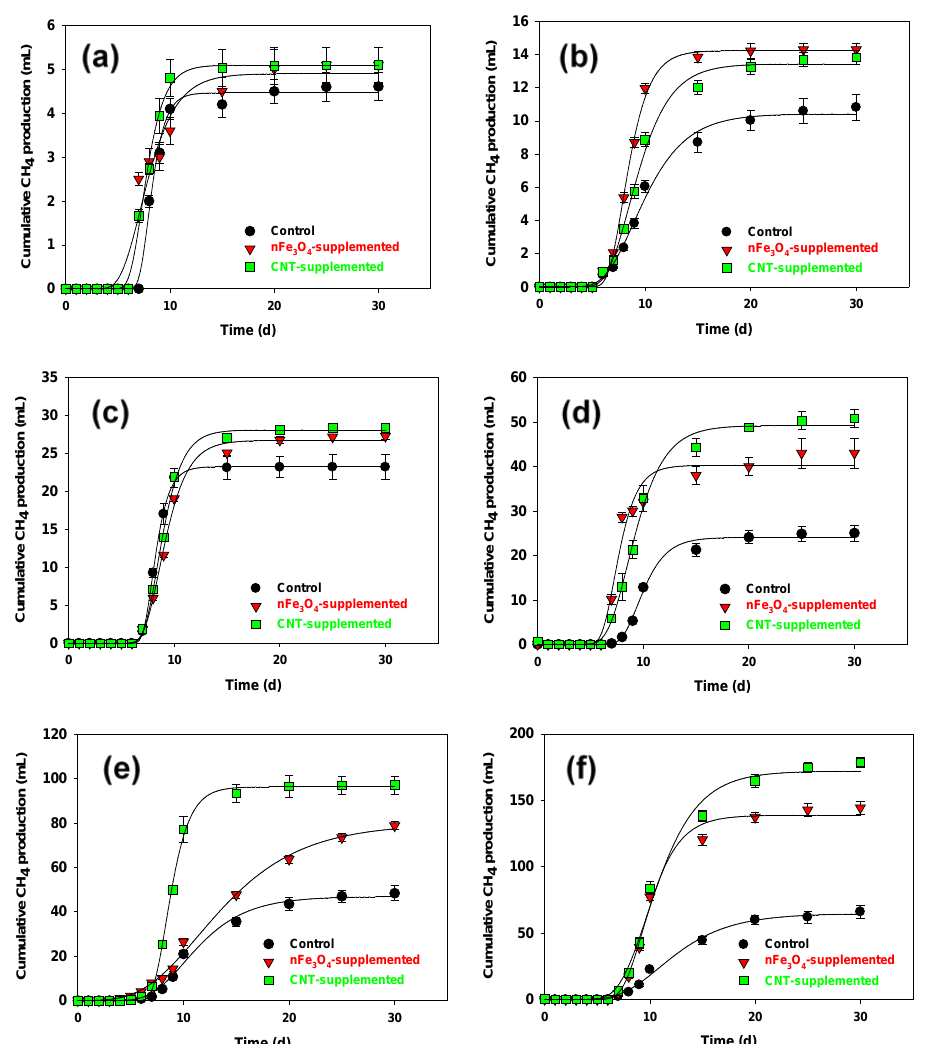
Figure 1. Effect of supplementing nFe 3 O 4 and CNT on cumulative CH 4 production from oleic acid at concentrations (g COD/L) of (a) 0.10, (b) 0.25, (c) 0.50, (d) 1.00, (e) 2.00, and (f) 4.00.